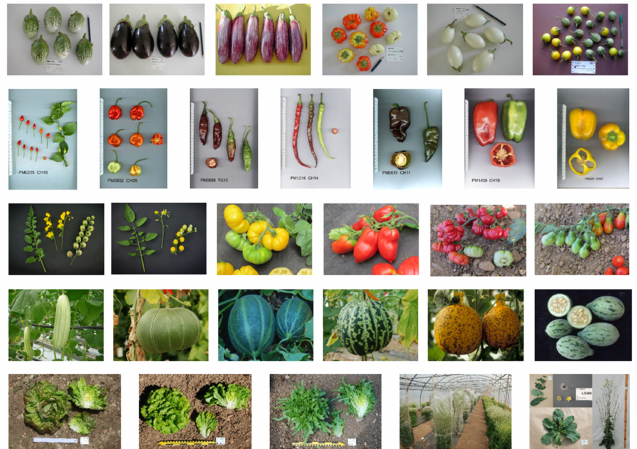
Figure 3. Illustrations of examples of the phenotypic diversity present in the five collections.